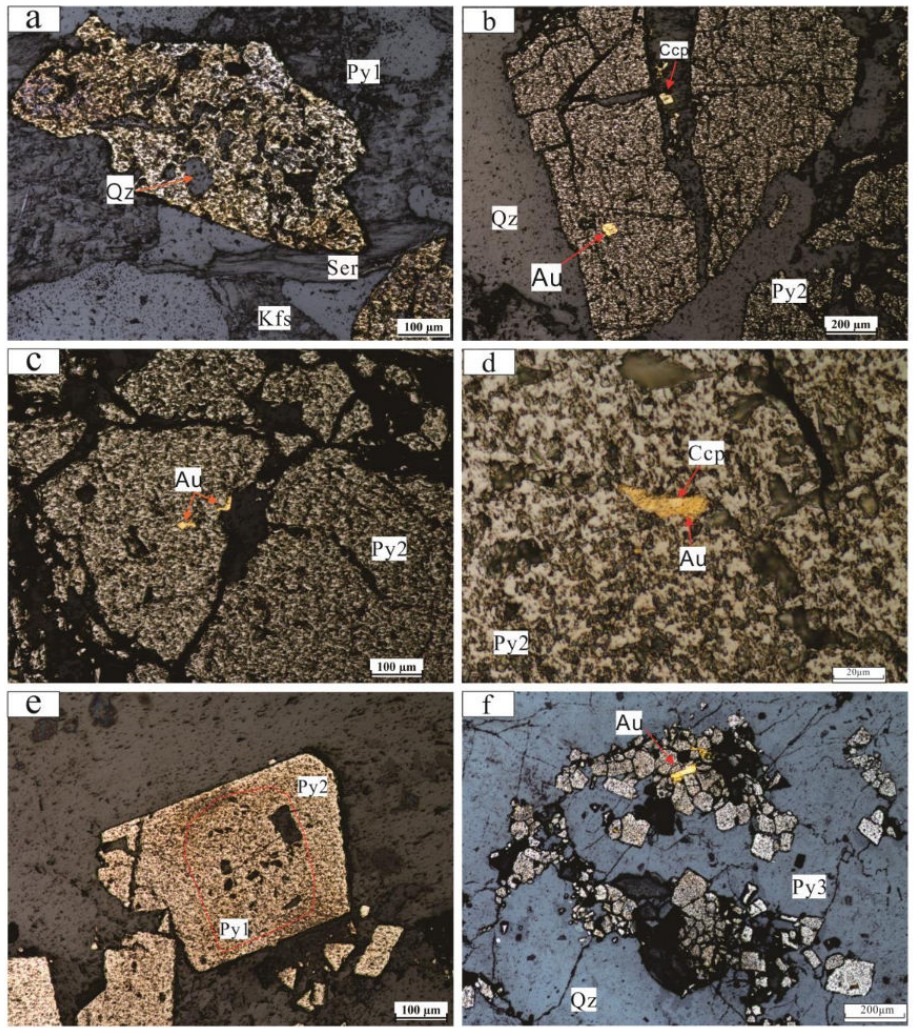
Figure 9. Reflected light photomicrographs of generations of pyrite. ( a ) Py1 characterized by micro-fractures and porous and filled with quartz. ( b ) and ( c ) Py2 characterized by micro-fractures and represent the largest grains. Au occurs as inclusions or stringers along the micro-fractures and crystal boundaries. ( d ) Native gold growing with chalcopyrite along micro-fractures in Py2. ( e ) Py 1 present in the core and Py 2 surround it as a rim ( f ) fine-grained Py3 growing with native gold. Ser: sericite; Ccp: chalcopyrite Qz: quartz; Kfs: